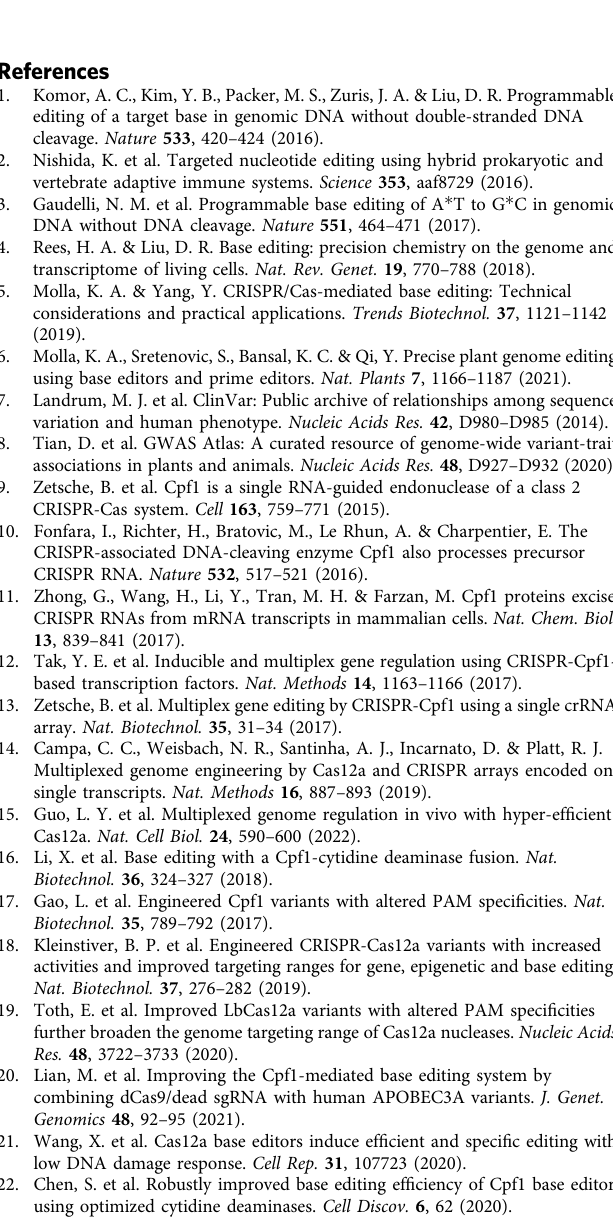
Table 1 can be found in Supplementary Data 1. The expression plasmids are available from addgene (accession IDs: 193638 to 193662). Other materials supporting the fi ndings of this study are available upon reasonable